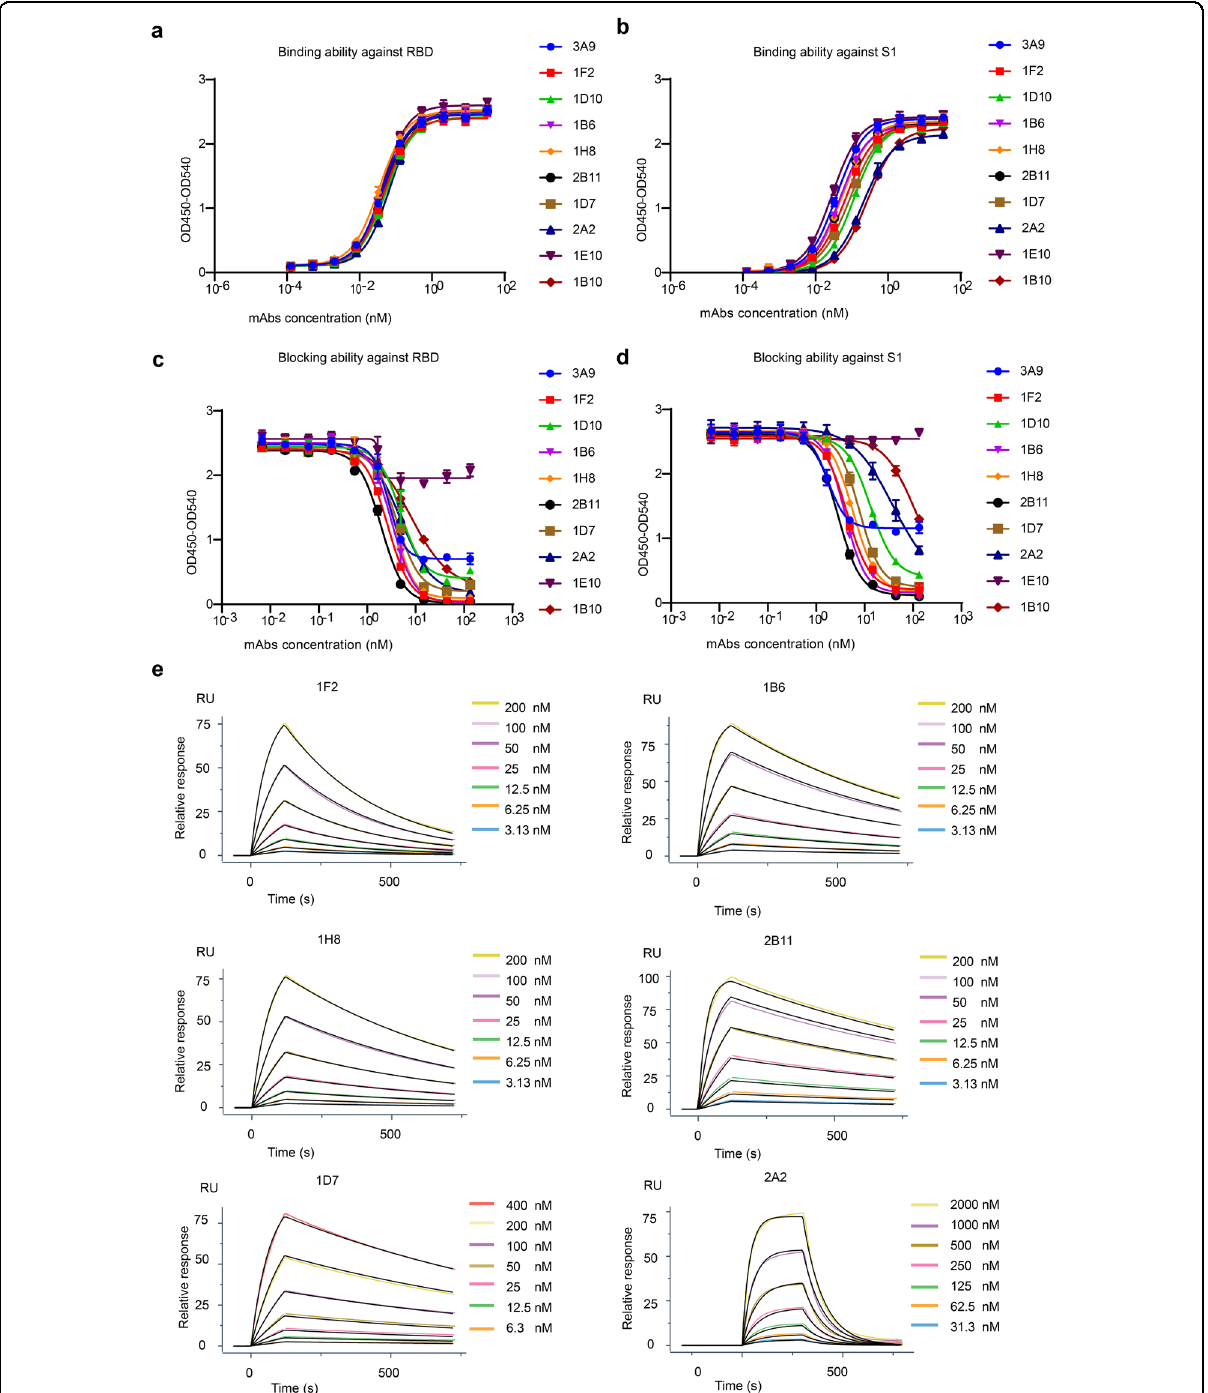
Fig. 2 Identi fi cation of SARS-CoV-2-neutralizing mAbs. The binding ability of the antibodies to RBD ( a ) and S1 ( b ) was measured via binding ELISA. The blocking ability of antibodies toward RBD ( c ) and S1 ( d ) was measured via competition ELISA. e The dissociation constants of the representative mAbs against the S1 protein were determined using SPR. K D was calculated using a 1:1 binding